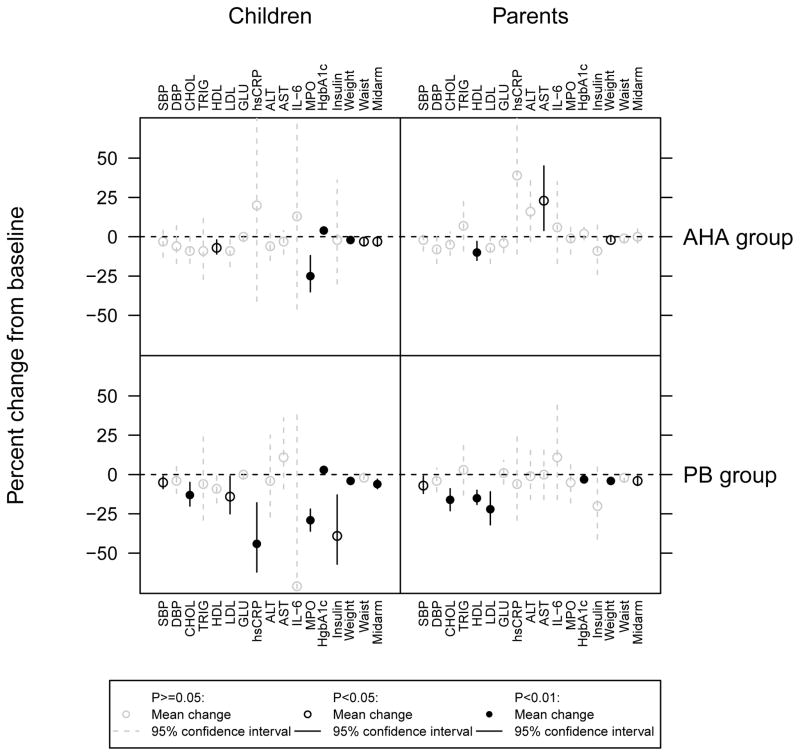
Clinical Outcomes Within GroupsSBP-Systolic Blood Pressure, DBP-Diastolic Blood Pressure